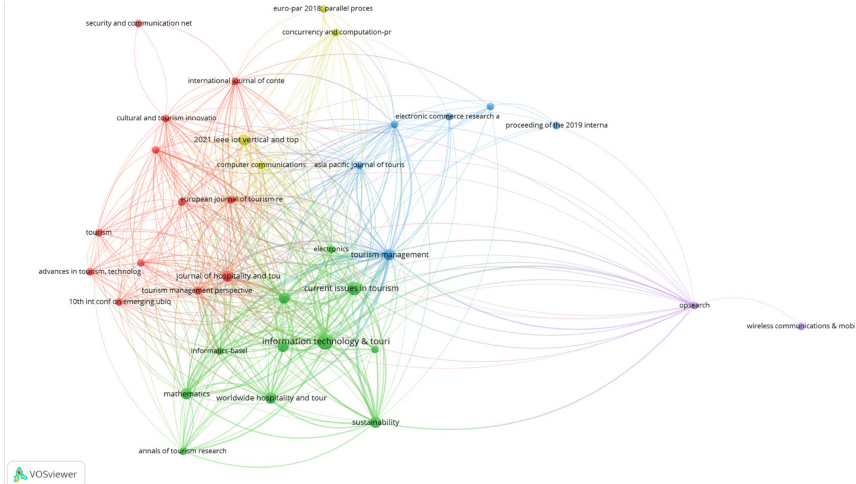
Figure 10. Citation and co-citation. Source: Analysis by Authors through